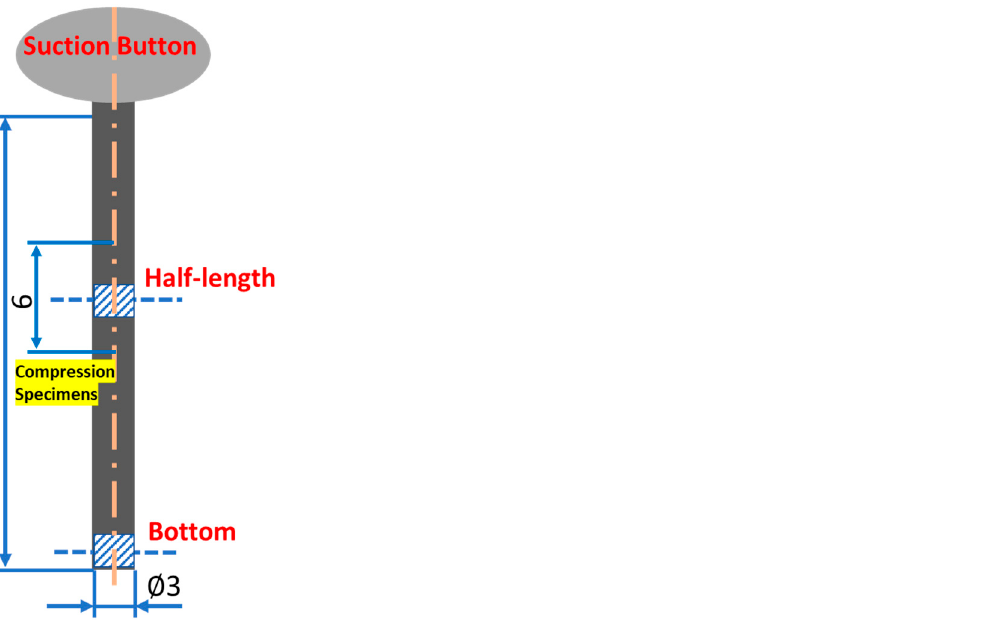
Figure 1. Schematic diagram showing the locations for metallography and compression test specimens.